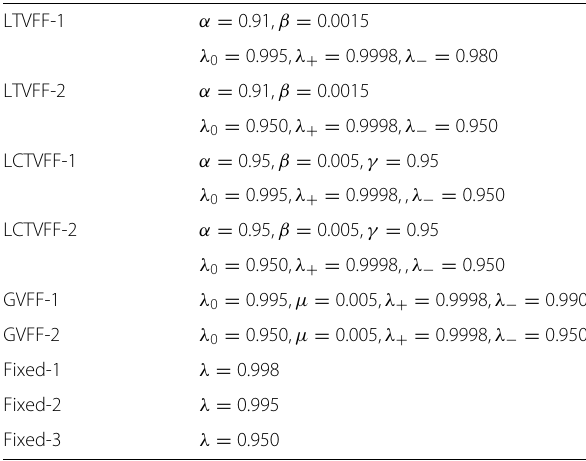
Table 4 Optimized parameters for different algorithms considered in Figs. 8 and 9